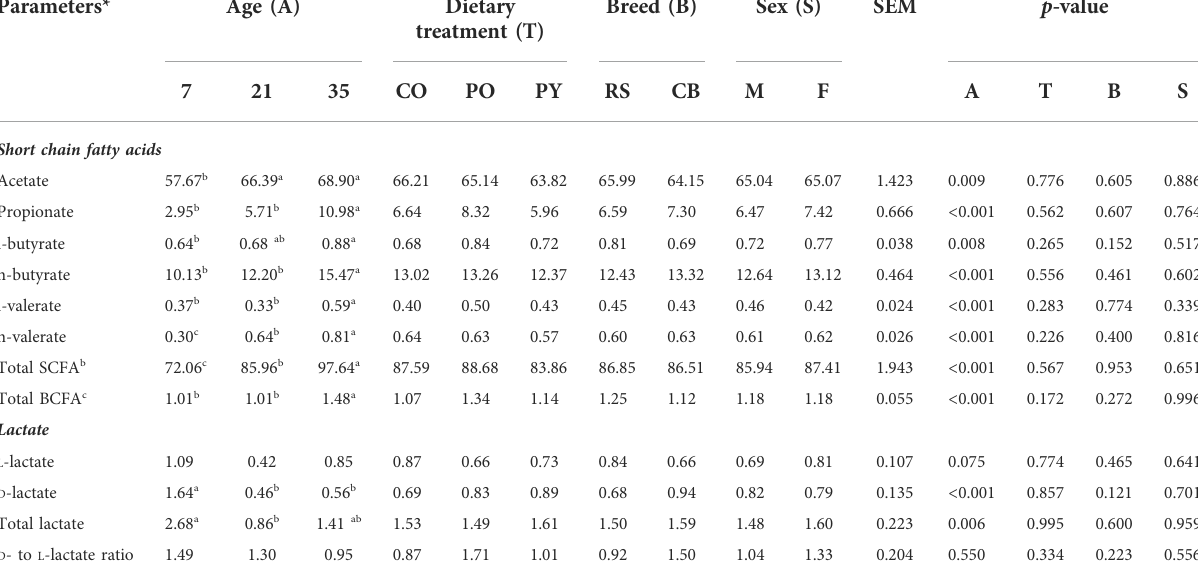
TABLE 4 The effect of age, dietary treatment, breed and sex on metabolite concentration (µmol/g of fresh sample) in the caecum a . Parameters* Age (A) Dietary Breed treatment (T)